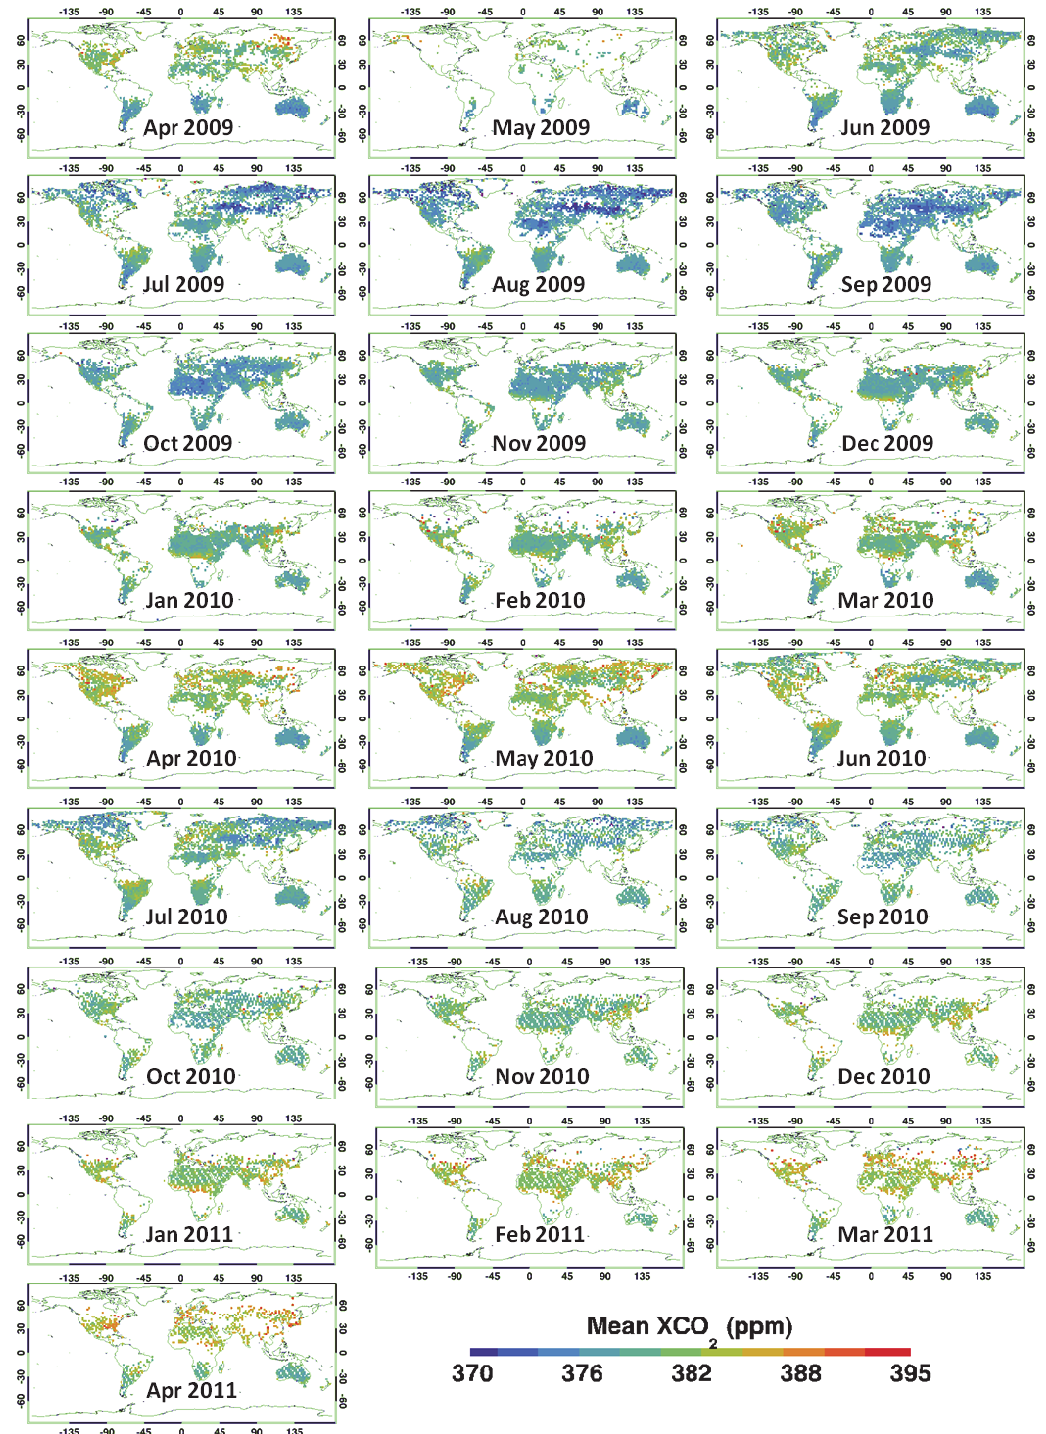
Fig. 11. ACOS GOSAT B2.8 X CO retrievals for April 2009–April 2011. Each map shows the X CO 2 Each symbol indicates the average of all X CO estimates in a 2 × 2 ◦ bin for that month that passed all pre- and post-screening filters. The 2 coverage in May 2009 is limited because TANSO-FTS was still being commissioned and few soundings were collected. The data used to create the maps can be obtained from the NASA GES